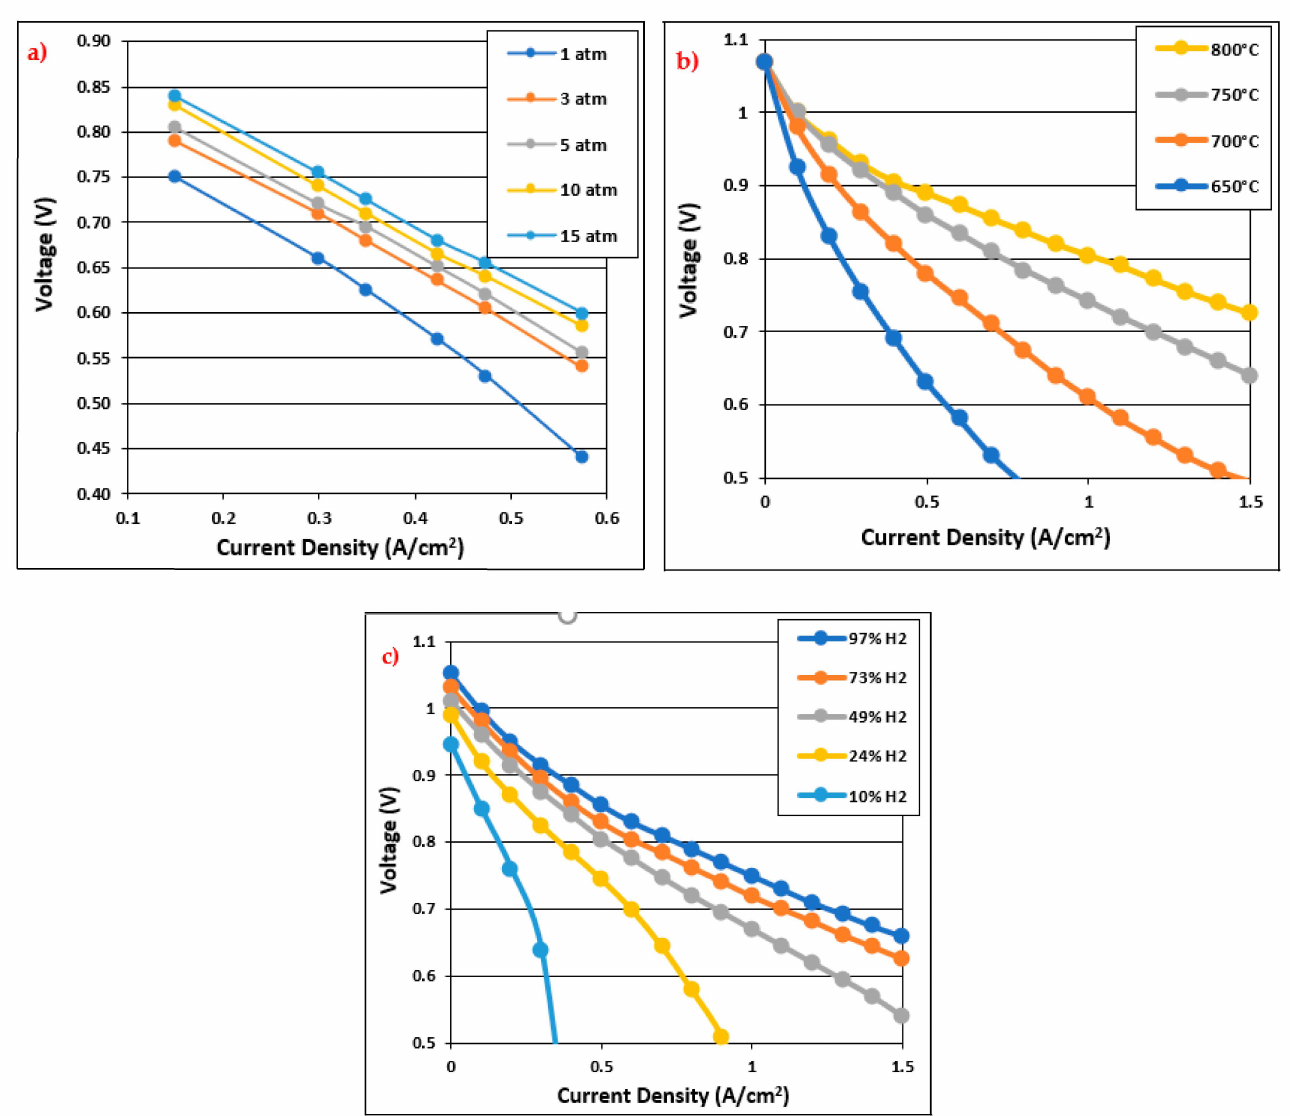
Figure 5. Our SOFC model data results validated against ( a ) Siemens Westinghouse stack pressure data ( b ) PNNL temperature data and ( c ) PNNL anode feed composition data.